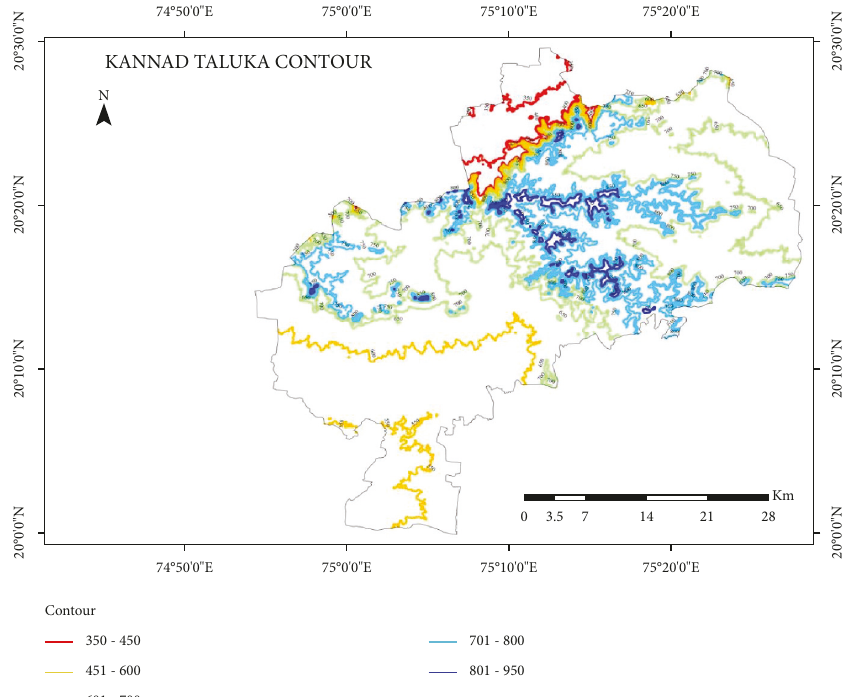
Figure 5: Contour line map of Kannad